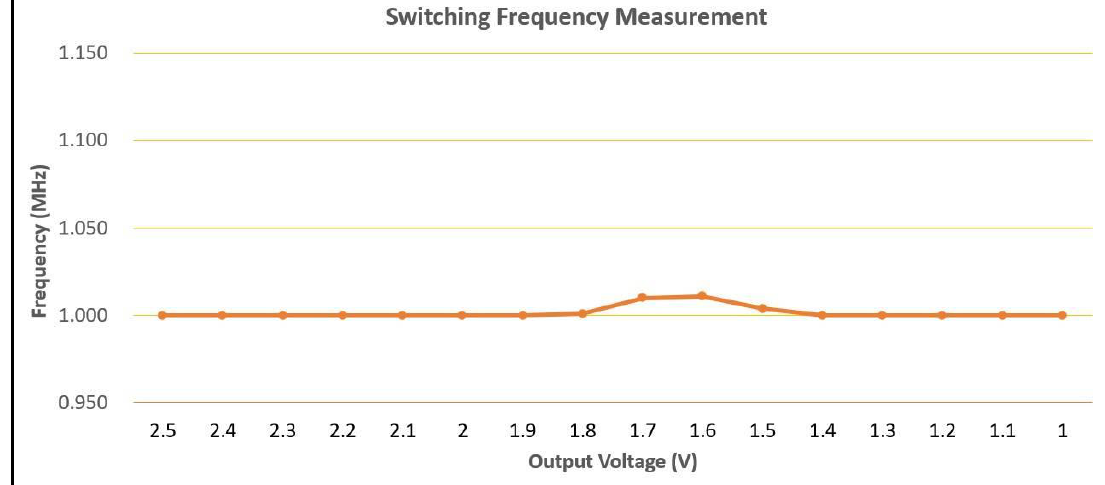
Table 2. Performance of Proposed